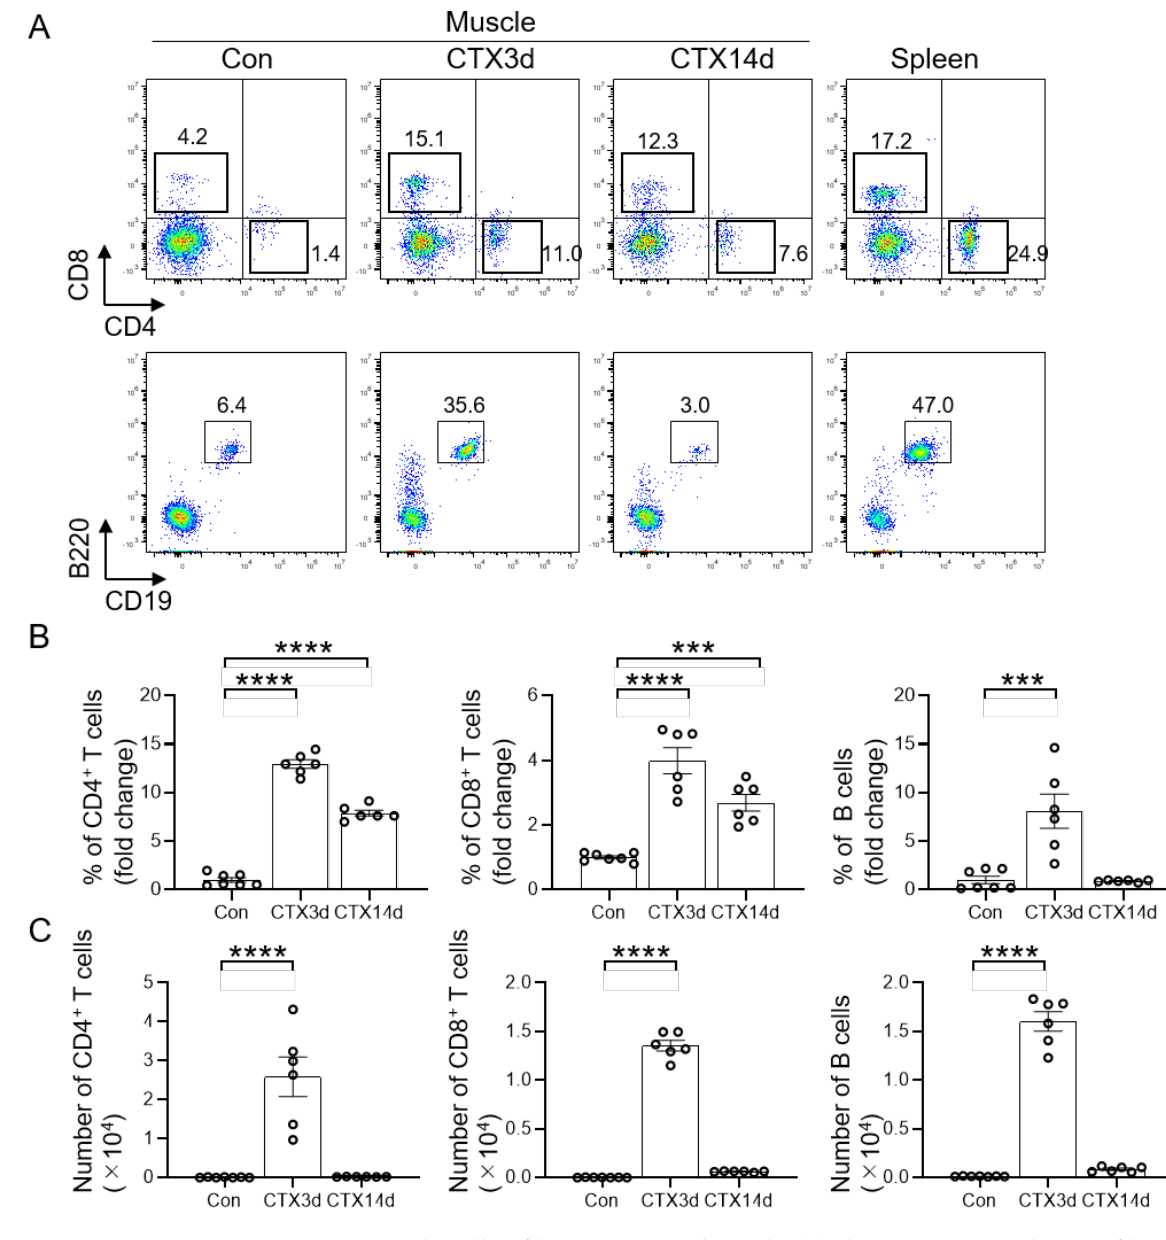
Figure 1. T and B cells infiltrate into injured muscle. ( A ) Flow cytometry analysis profiles of muscle- derived CD4 + T cells (helper T cells), CD8 + T cells (cytotoxic T cells), and B cells without injury, and at days 3 and 14 after injury. The gated profiles show T cells (CD4 + or CD8 + ) and B cells (B220 + CD19 + ). ( B ) Fold change in the percentage of CD4 + T cells, CD8 + T cells, and B cells in the CTX3d and CTX14d relative to the control group. ( C ) The number of T and B cells in the three groups was analyzed. Data represented as the mean ± SEM (one-way ANOVA followed by Dunnett’s post hoc test: *** = p < 0.001, **** = p < 0.0001; n = 6–7 per group).